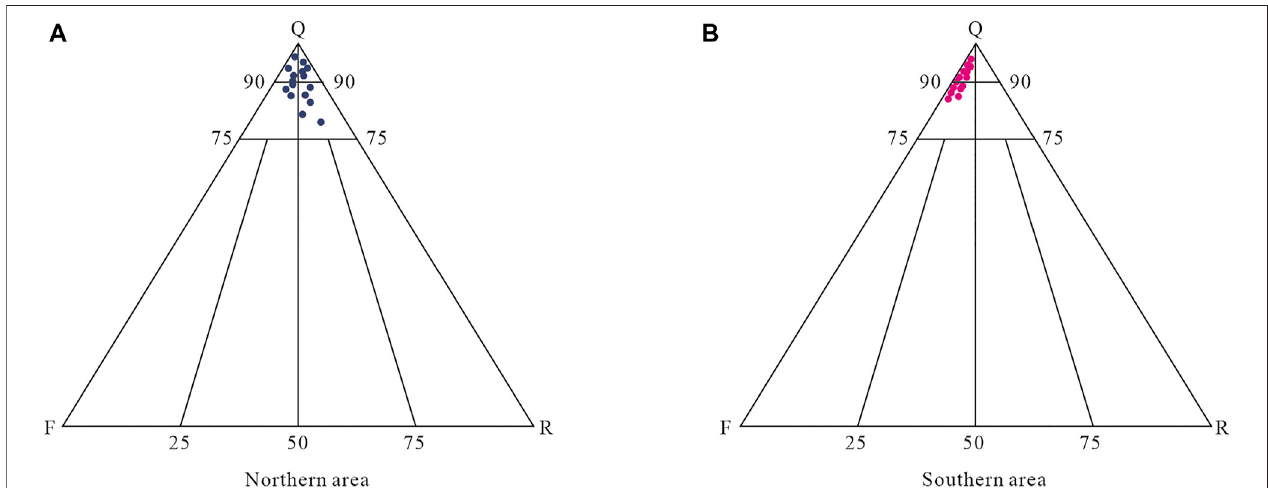
FIGURE 4 | Constituents of the Xiaoheba Formation sandstone types in the study area. (A) Northern, (B) Southern.